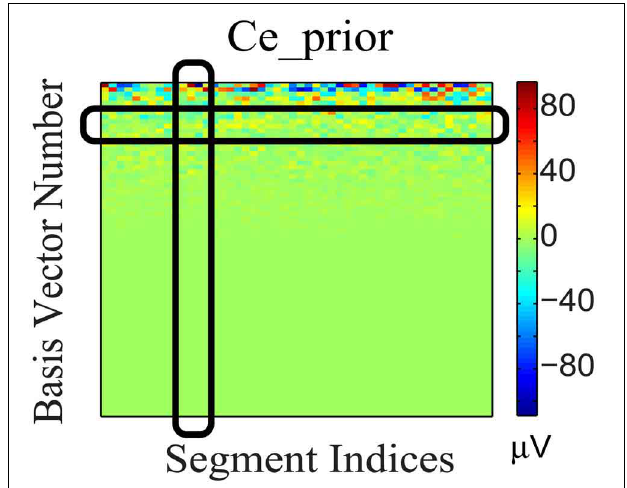
FIGURE 5 | Coefficient matrix (C e _ prior ) of the EEG prior data. The black column and row highlights show that C e _ prior is sparse in basis vector representation (column) and dense across segments